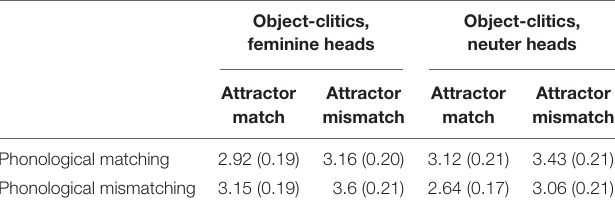
TABLE 10 | Participants’ mean ratings and standard error in Experiment 4 grouped by Phonological